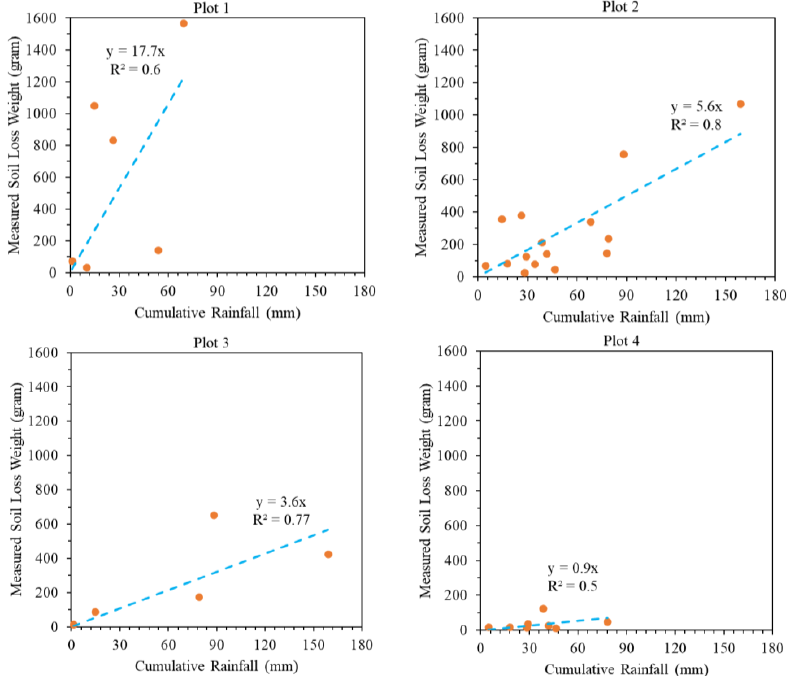
Figure 10. Relationship between the soil loss weight and cumulative rainfall depth from storms that occurred between two site visits to erosion Plots 1 to 4.